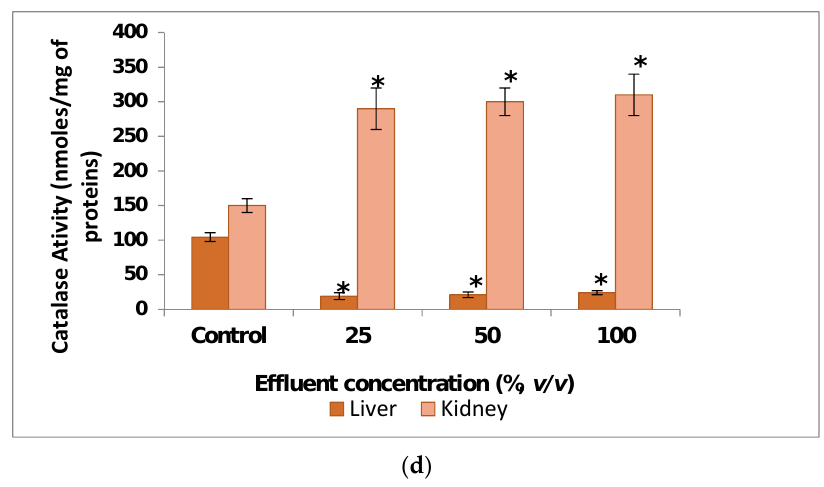
Figure 1. Results of the biochemical biomarkers [MDA level ( a ), CDs level ( b ) SHP activity ( c ), and catalase activity ( d )] in the mice’s liver and kidney after 90 days exposure to various dilutions of TDE. Data are expressed as mean ± standard Deviation. Values are significantly different * p < 0.05 compared to the corresponding negative controls using one-way ANOVA followed by post hoc Tukey’s test.